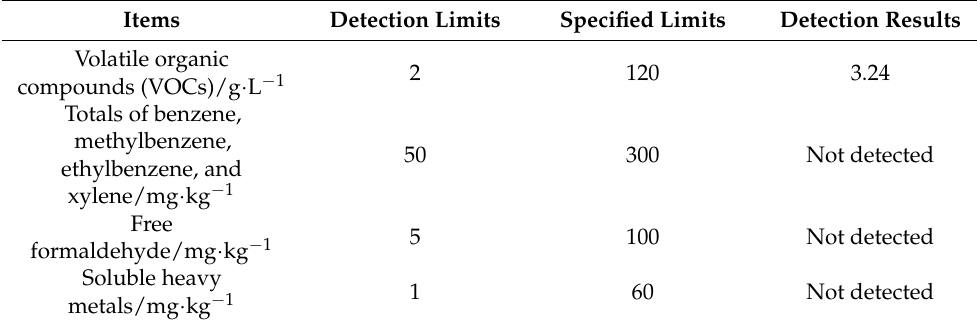
Table 5. Contents of hazardous substances in dust suppressants.